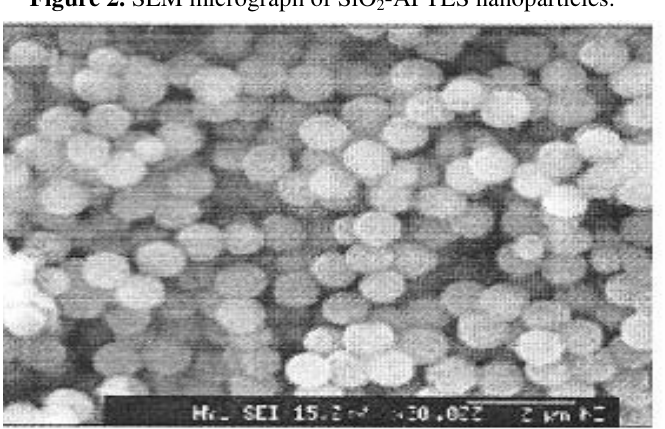
Figure 2. SEM micrograph of SiO